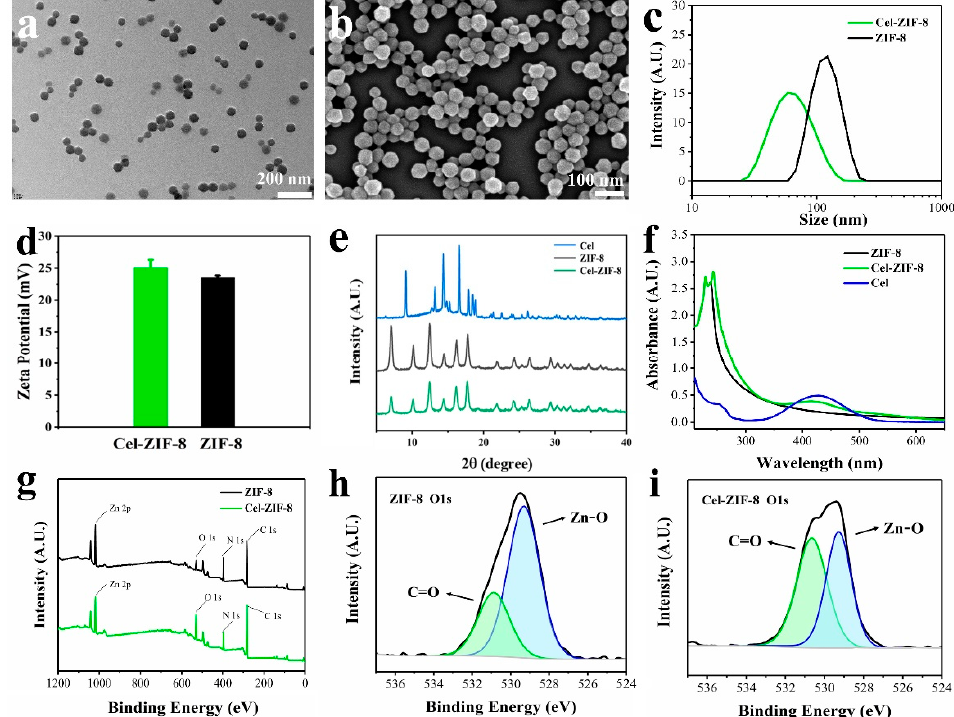
Figure 1. Characterization of Cel-ZIF-8. ( a , b ) Transmission electron microscope (TEM) and scanning electron microscope (SEM) images of Cel-ZIF-8 NPs. ( c ) Particle sizes of Cel-ZIF-8 and ZIF-8 detected by dynamic light scattering (DLS). ( d ) Zeta potentials of Cel-ZIF-8 and ZIF-8 detected by a Zetasizer ( n = 3, error bars represent standard deviation of the 3 trials). ( e ) PXRD results of Cel-ZIF-8, ZIF-8, and Cel. ( f ) UV-Vis absorption spectra of Cel-ZIF-8, ZIF-8, and Cel. ( g ) XPS spectra of Cel-ZIF-8 and ZIF-8 NPs. ( h , i ) The fitting results of O 1s spectra from XPS spectra of ZIF-8 and Cel-ZIF- 8.